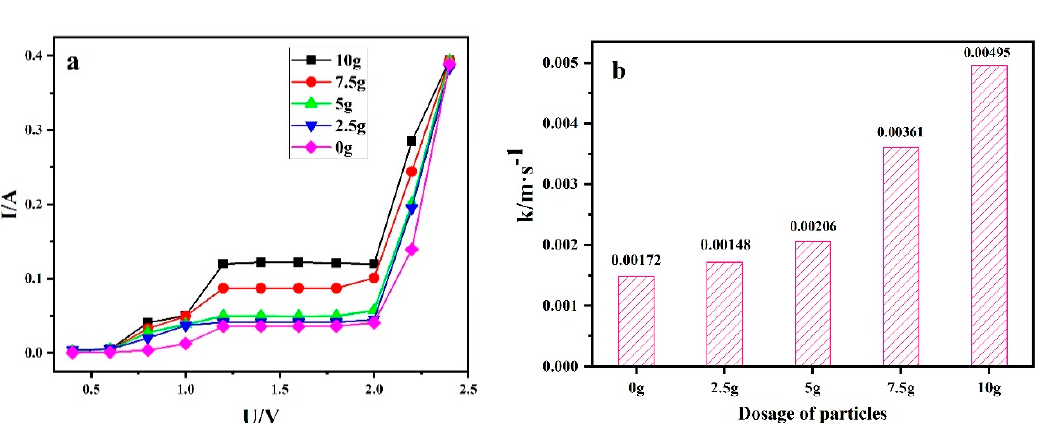
Figure 1. ( a ) Ampere–voltage of different particle dosage ( b ) the corresponding mass transfer coefficient.